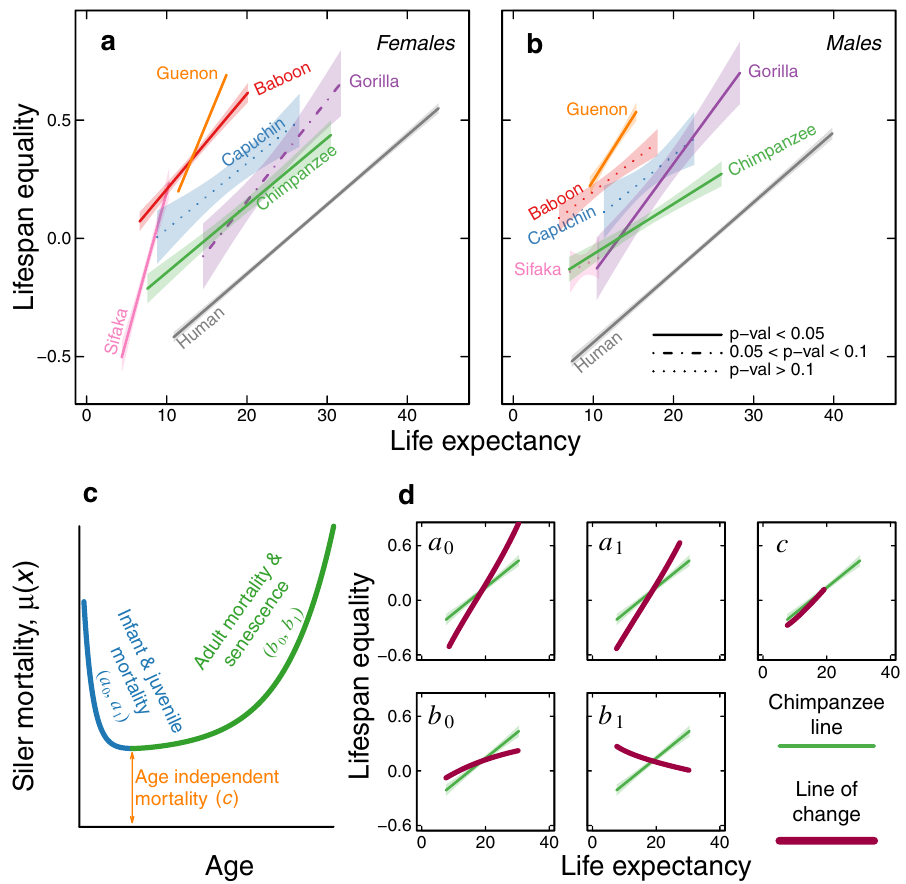
Fig. 1 The life expectancy – lifespan equality landscape for seven genera of primates for for both sexes. a Life expectancy and lifespan equality regression lines for females; each species is represented by a different colour. b Life expectancy and lifespan equality regression lines for males. Each genus is characterised by a relatively constrained relationship between life expectancy and lifespan equality, and thus a distinct regression line; colours as in a . The central lines are the predicted fi tted values of the regression and the type of line (e.g. continuous, dashed, or dotted) depicts three levels for the p values of the slopes (how signi fi cantly different from 0 they are, two-sided t test, H 0 : β 1 = 0, Supplementary Table 1), while the shaded polygons show the 95% con fi dence intervals of the regressions. c The relationship between the Siler mortality parameters and the resulting mortality function, given by the equation μ ( x ) = exp( a 0 – a 1 x ) + c + exp( b 0 + b 1 x ), where infant and juvenile mortality (blue) are controlled by parameters a 0 and a 1 , age-independent mortality (orange) is captured by c , and senescent mortality (green) is captured by b 0 (initial adult mortality) and b 1 (rate of ageing). d Each box shows how gradual changes in each Siler mortality parameter modify the life expectancy and lifespan equality values (thick purple lines). The green line in each box corresponds to the regression line for female chimpanzees, shown for reference to illustrate the general trends among all genus lines. The purple curves show the changes in life expectancy and lifespan equality after varying individual Siler parameters while holding the other parameters constant. Note the striking change in life expectancy and lifespan equality that would result from changes in the ageing parameters, particularly b 1 . See Supplementary Fig. S3 for plots that include individual points for each population. Source data to generate the regression lines are available in Supplementary Data